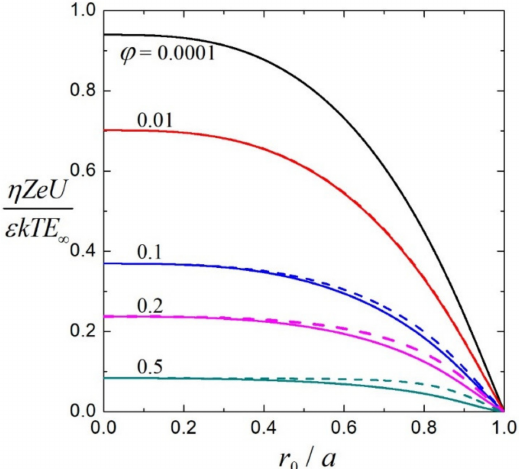
Figure 7. Scaled electrophoretic mobility η ZeU / ε kTE ∞ versus r 0 / a for a suspension of soft spheres with Q = 4, λ a = 10, and ϕ as a parameter for the Happel model. The solid and dashed curves denote results obtained from conditions (13) and (14), respectively, at the cell border.